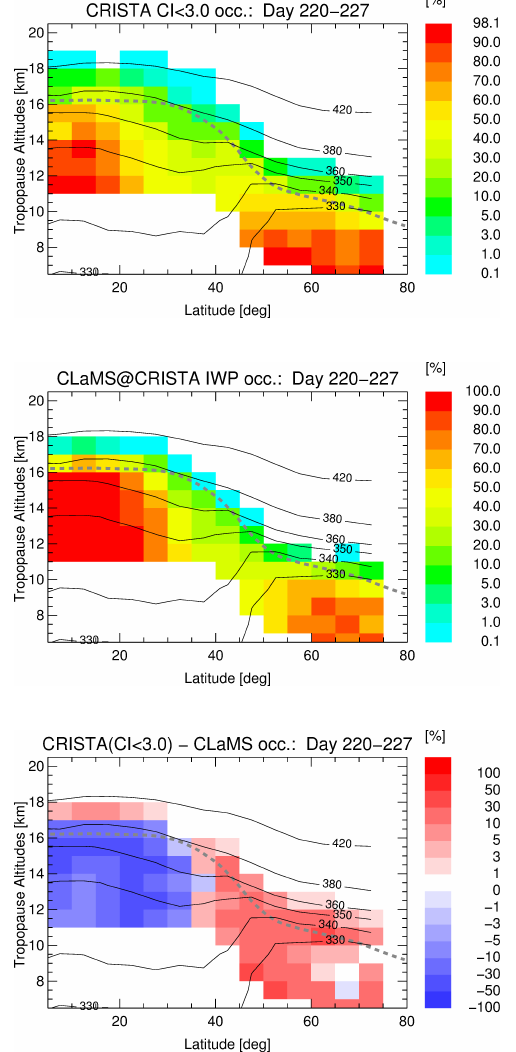
Figure 9. Cloud top height occurrence frequencies in tropopause related vertical coordinates for the complete measurement period (7 days) of CRISTA-2 (top) based on CI thres = 3. The correspond- ing CLaMS model is sampled with the lines of sight of CRISTA, and cloud top detection is based on IWP>0 (middle). Differences in cloud top height occurrence frequency between CRISTA and CLaMS sampled with CRISTA are presented in the bottom diagram. Contours for zonal mean isentropes (black) and for the zonal mean tropopause altitude (dashed grey) are superimposed.